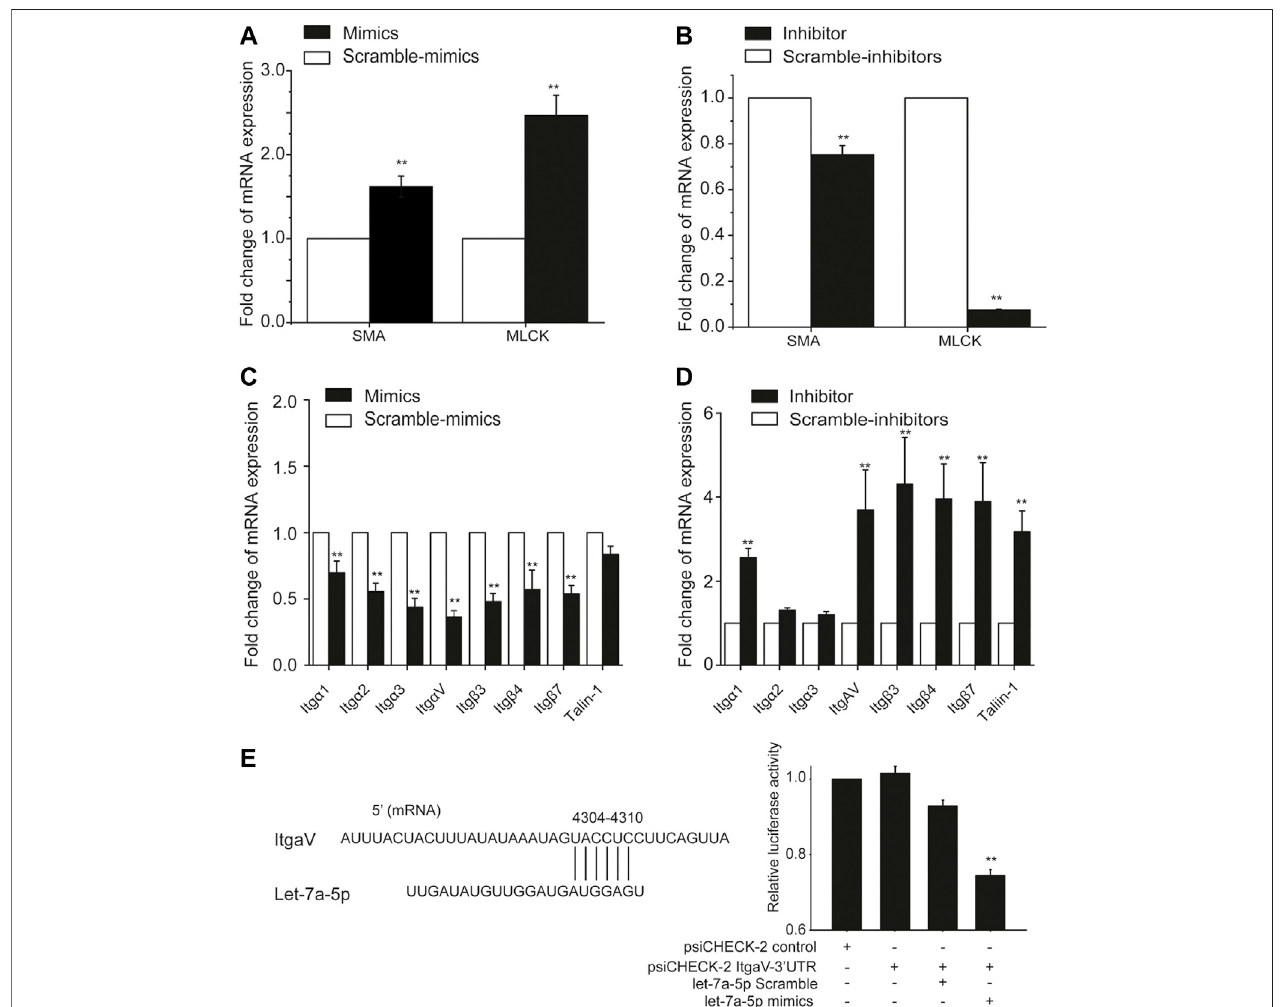
FIGURE5| TheexpressionofmRNAassociatedwithbiomechanicalpropertiesinASMCsdetectedwithmRNAqRT-PCR.ThefoldchangeofmRNAexpressionof MLCK and SMA in ASMCs after treatment with let-7a-5p mimics (A) , inhibitors (B) , and related scramble controls. The fold change of mRNA expression of focal adhesion-associated molecules such asintegrin,vinculin, and talin in ASMCsafter treatment withlet-7a-5p mimics (C) , inhibitors (D) ,and relatedscramblecontrols. (E) Itg α V was targeted by let-7a-5p analyzed by double-luciferase experiments. The schematic sequence cloned in psiCHECK plasmids was shown on left, and the relative luciferase activity in HEK293T cells treated with or without let-7a-5p mimics was shown in right. Data are means ± S.E.M., n = 3. ** p < 0.01.